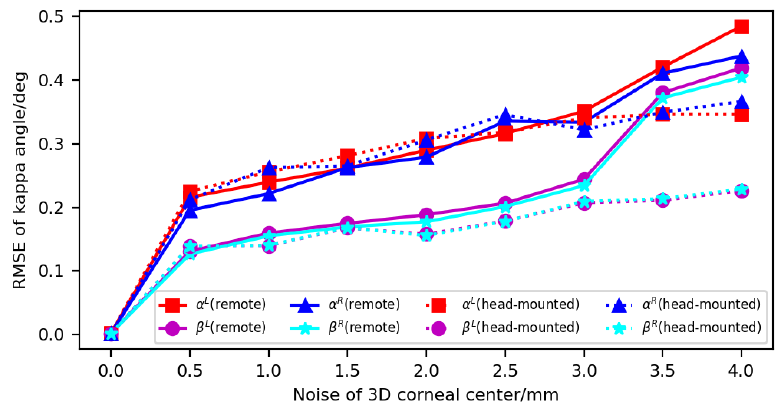
Figure 7. Influence of 3D-corneal-center error on kappa-angle calibration.